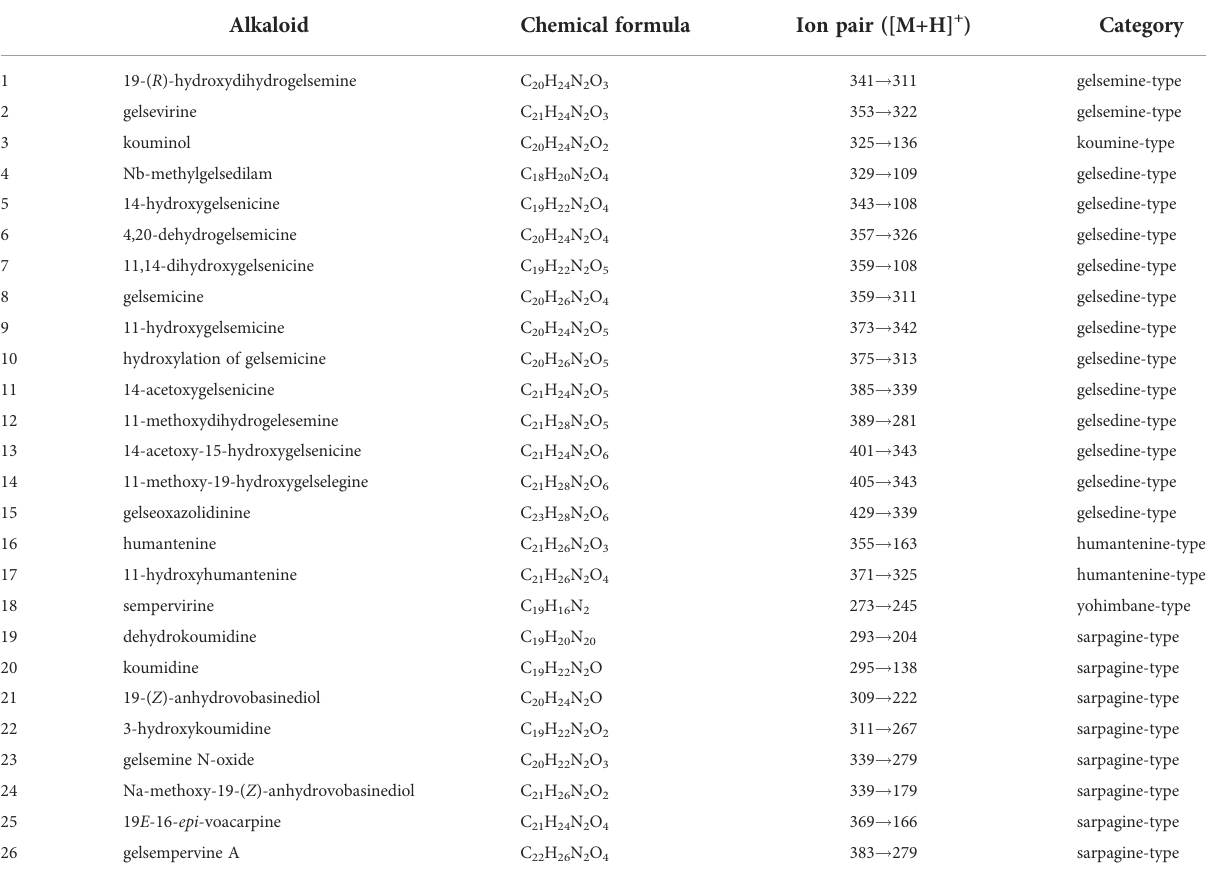
TABLE 1 Identi fi ed alkaloids in Gelsemiume legans